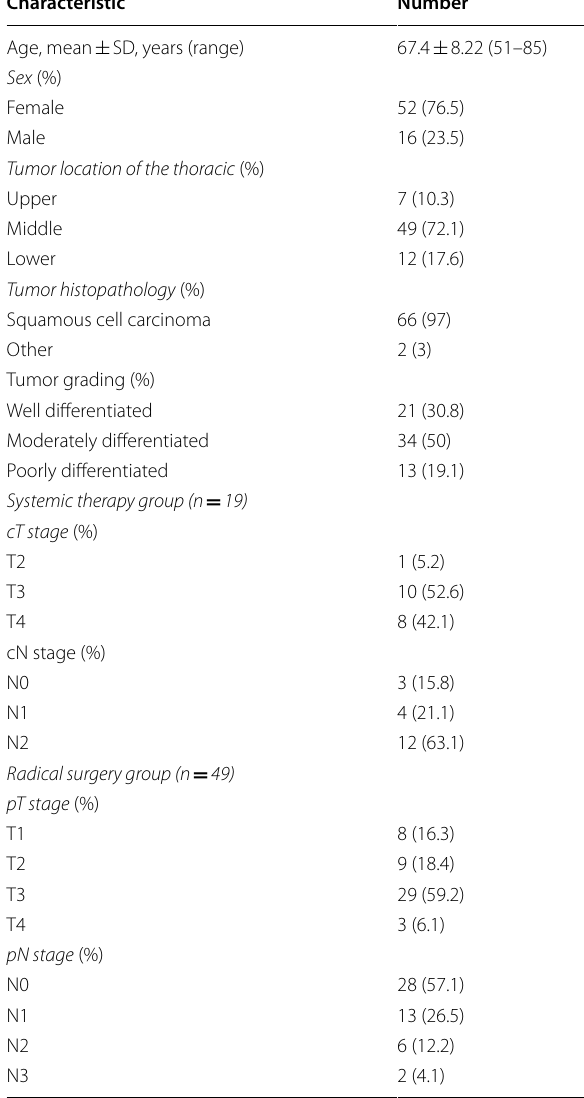
Table 1 Patient clinicopathological data of esophageal cancer patients